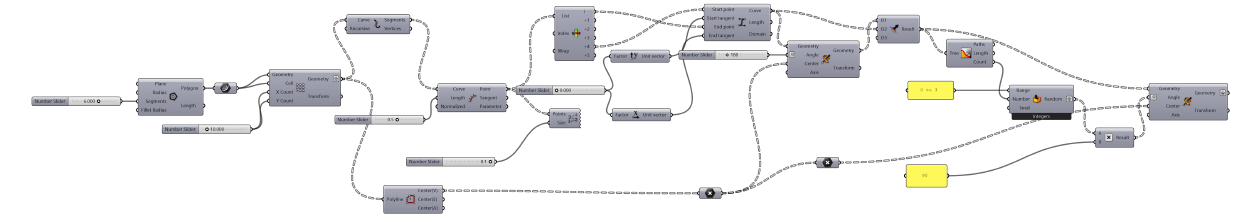
Figure 5. Process workflow in